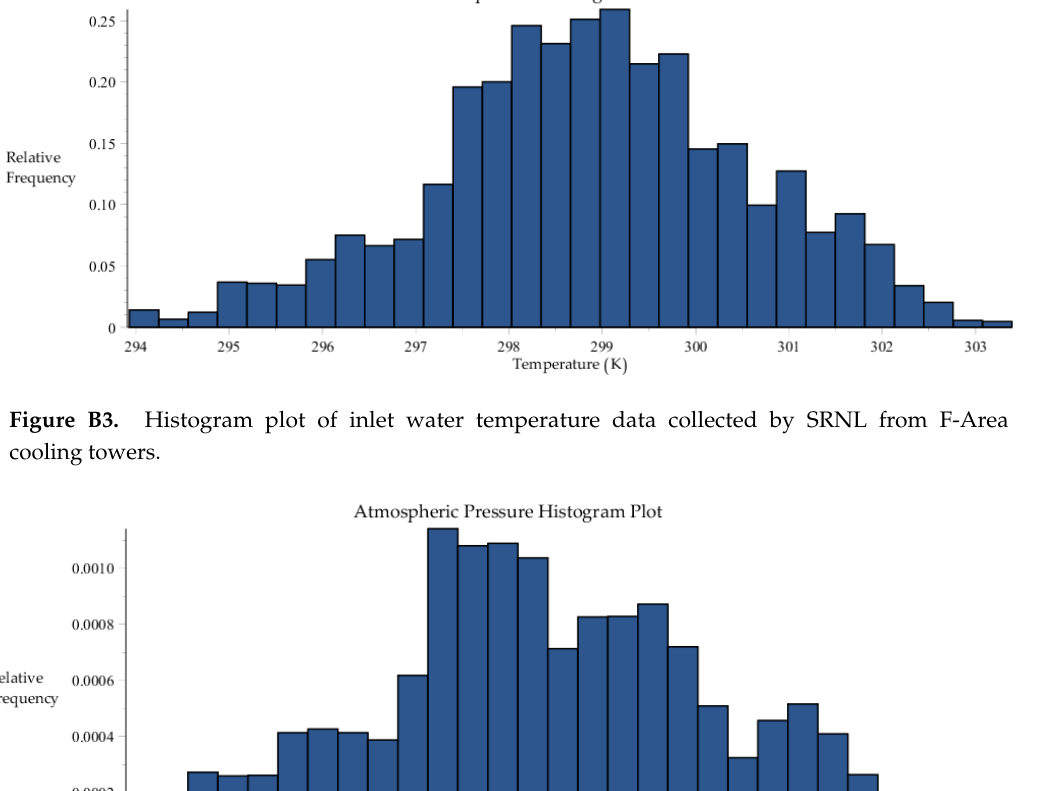
Figure B5. Histogram plot of wind speed data collected by SRNL from F-Area cooling towers. Table B4. Statistics of the dry-bulb temperature (set to air inlet temperature) distribution [K]. Minimum